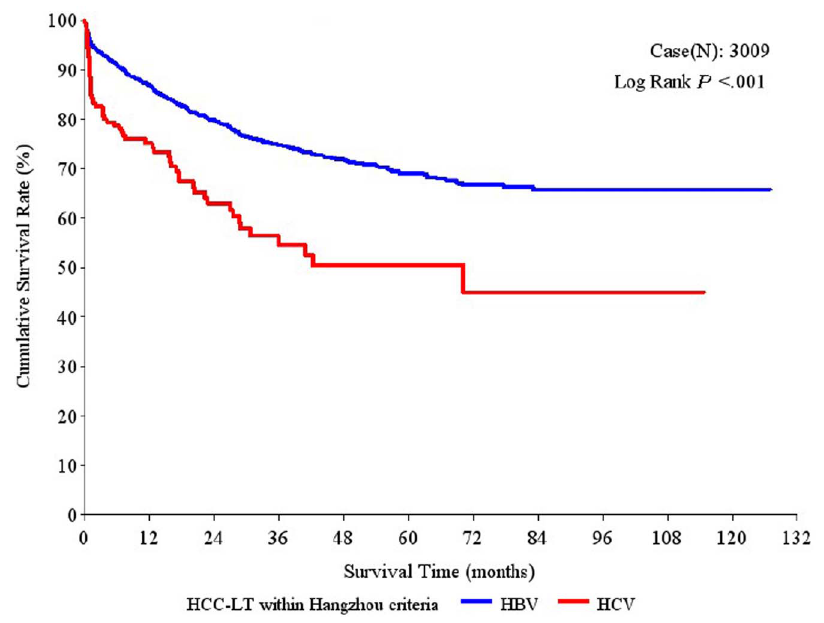
Figure 2. Overall survival rates after liver transplantation (LT) in patients with hepatitis B virus (HBV)-associated hepatocellular carcinoma (HCC) and hepatitis C virus (HCV)-associated HCC who met the Hangzhou criteria.